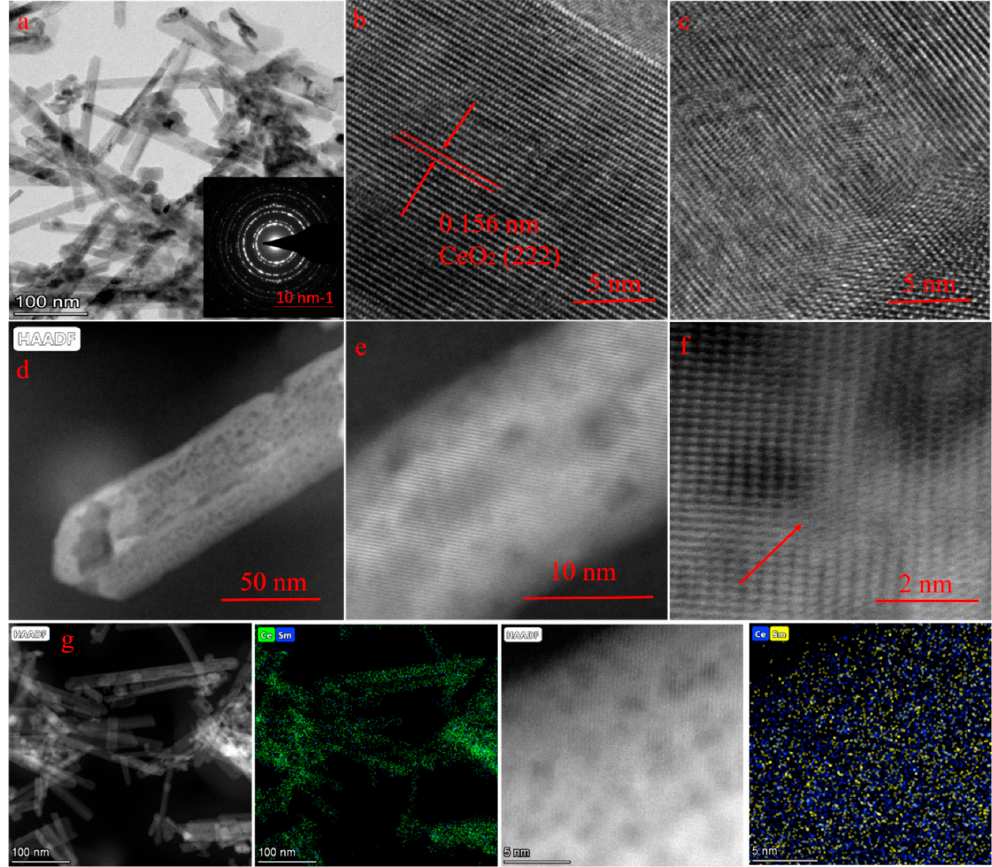
Figure 2. ( a ) Transmission electron microscope (TEM) images of Vo–Sm–CeO 2 , high resolution transmission electron microscopy (HR-TEM) of ( b ) CeO 2 , and ( c ) Vo–Sm–CeO 2 , ( d – f ) high-angle